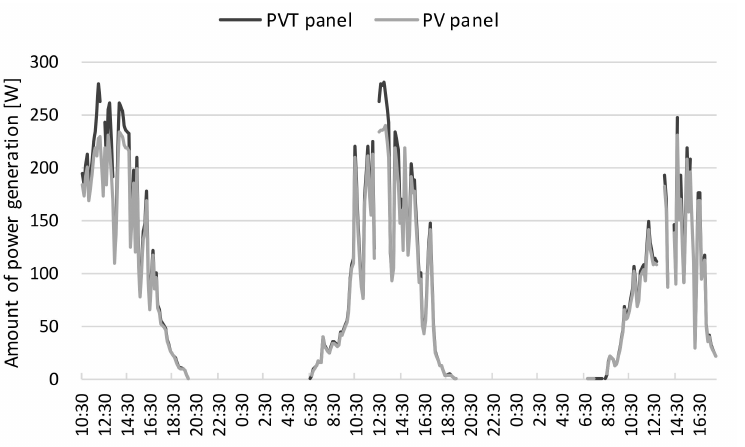
Figure 10. Variations in power generation of photovoltaic (PV) and PVT panels.